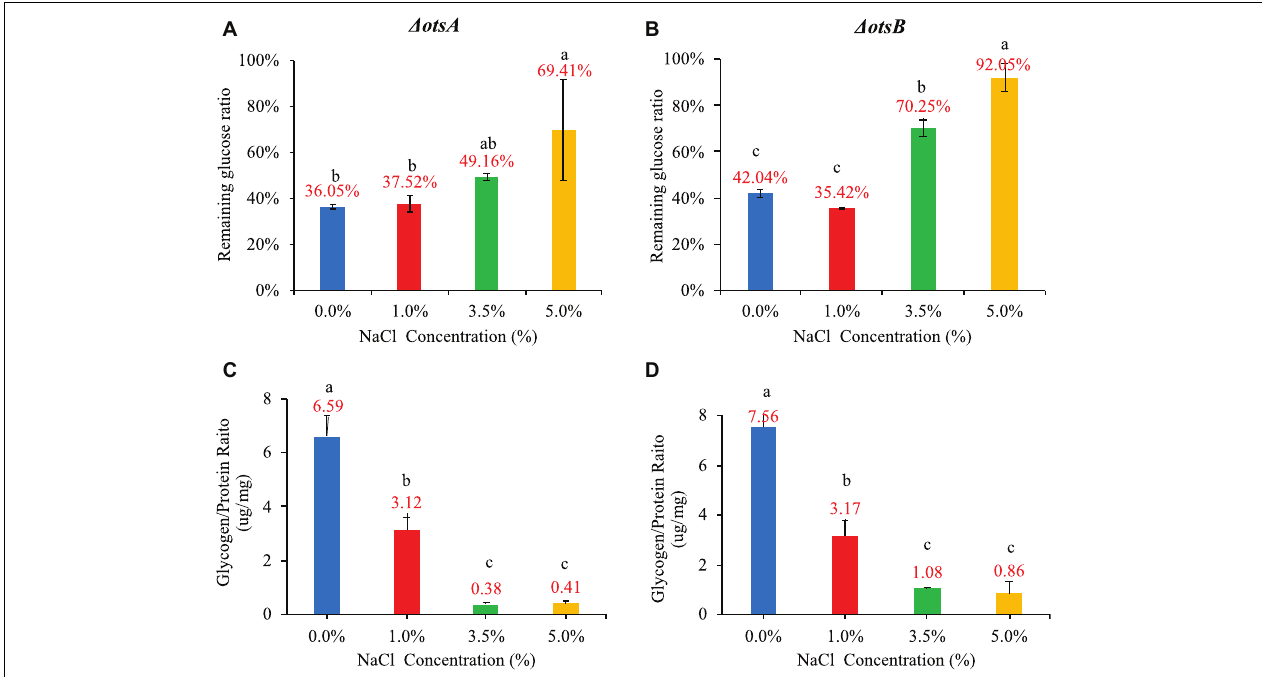
FIGURE 6 | Influences of NaCl concentrations (0, 1, 3.5, and 5%) on E. coli (cid:49) otsA and (cid:49) otsB in terms of glucose consumption rate and glycogen accumulation at 20 h. (A,B) Glucose consumption rates. (C,D) Glycogen accumulation capacity. Tukey’s Honestly Significant Difference (HSD) test was performed. Means denoted by a different letter indicated significant differences among groups ( P -value <